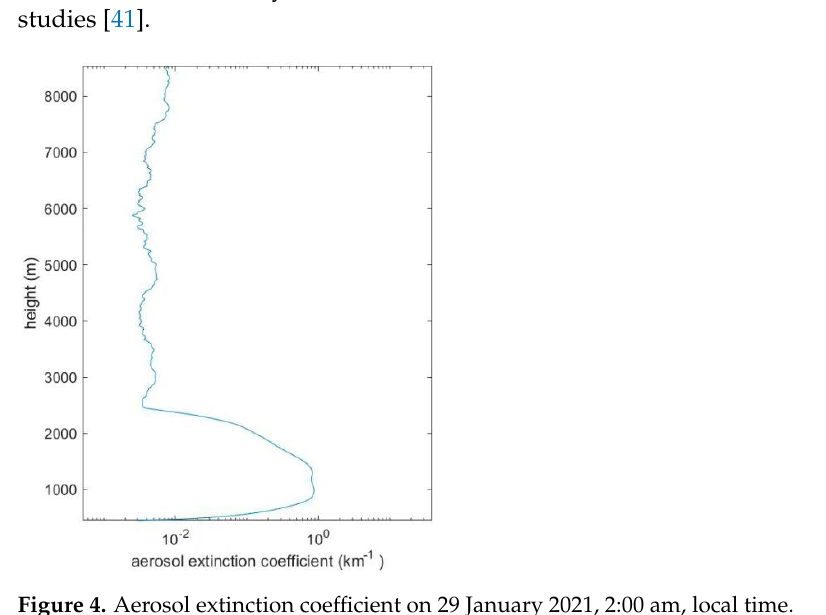
Figure 3. Daily average of boundary layer height in Hefei.